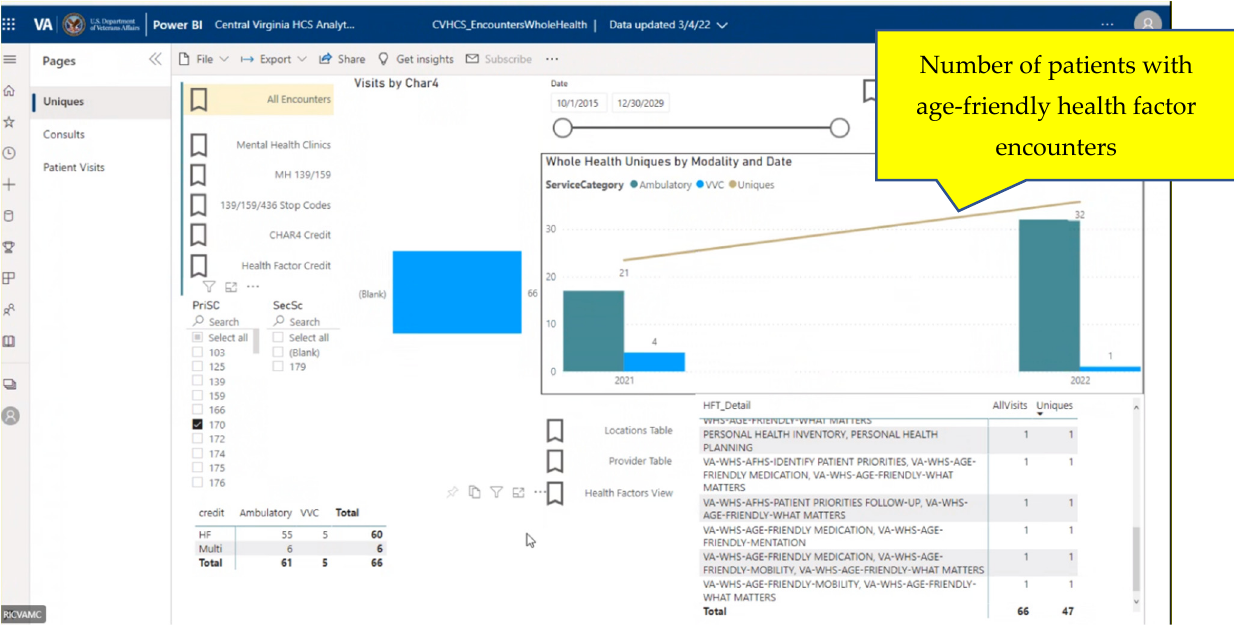
Figure 2. Whole health age-friendly dashboard (RICVAMC). Display visualizes the RICHVAMC age-friendly dashboard with health factors addressed over time in the Geriatric Primary Care Patient-Aligned Care Team (GeriPACT) population and Home-Based Primary Care (HBPC). For non-templated TVHS GeriPACT clinic notes over a 30-day period, all the 4Ms